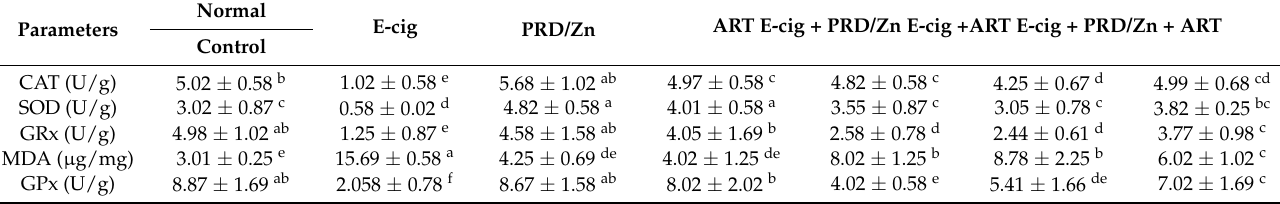
Table 3. Effects of E-cigs on pulmonary antioxidant enzymes and beneficial effects of PRD/Zn and ART in lung homogenates of male mice.